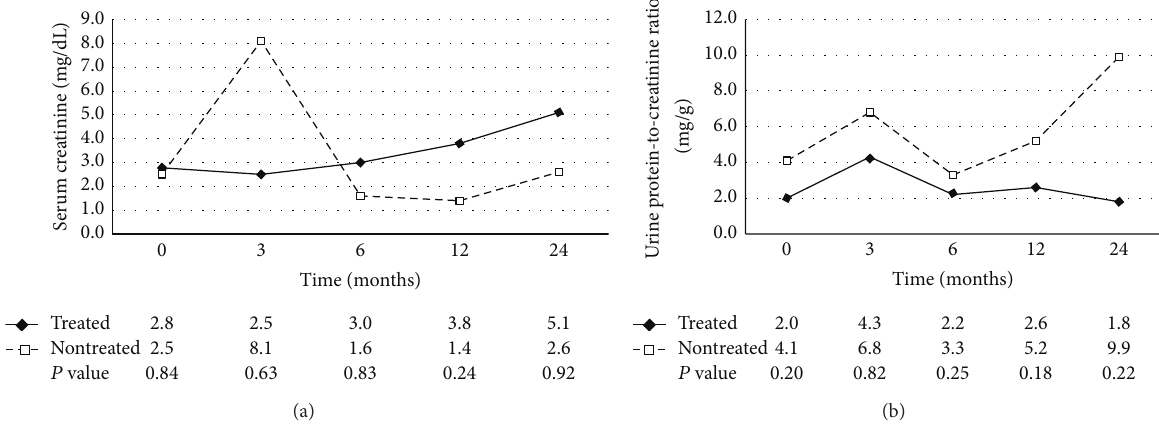
Figure 1: Changes in renal function as determined by serum creatinine level (a) and amount of proteinuria as determined by the urine protein-to-creatinine ratio (b) classified by antiviral treatment over time. Degree of proteinuria was not reduced, and renal function was not significantly improved in the antiviral intervention group when compared to the control group.